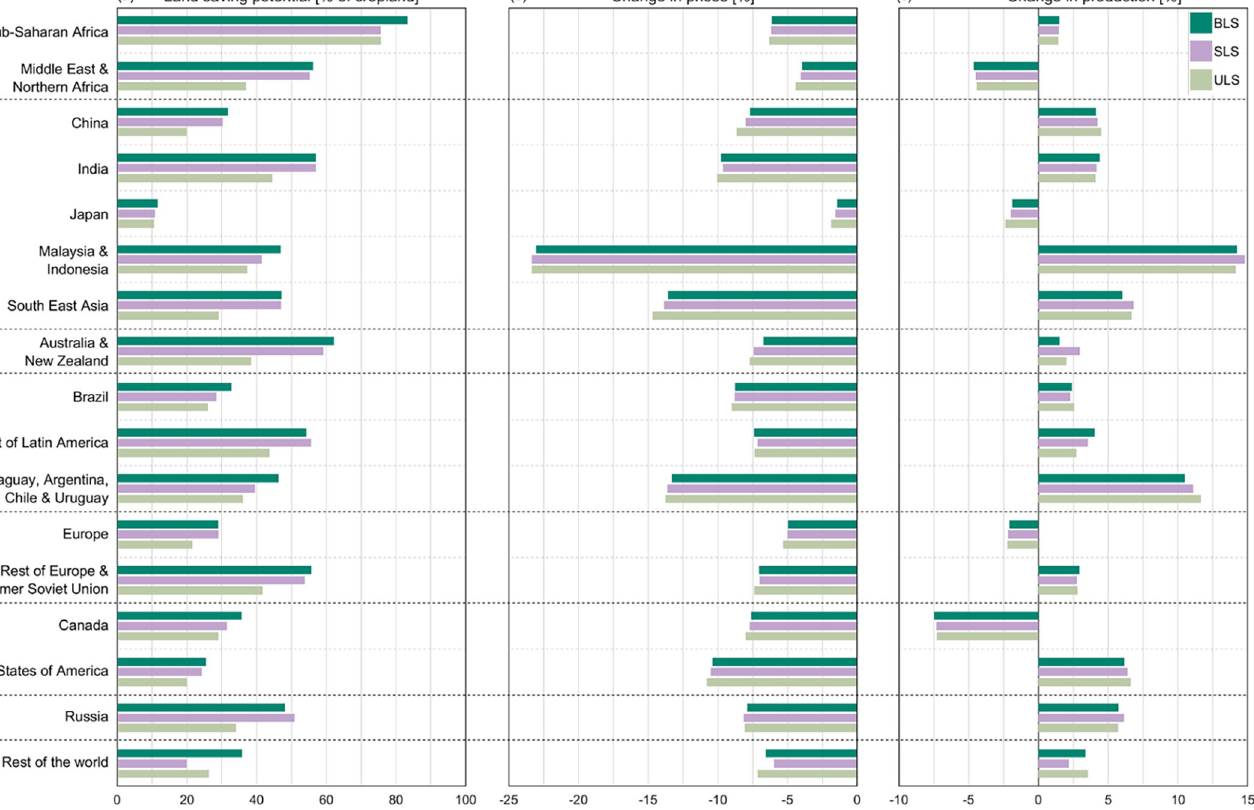
PLOS ONE | https://doi.org/10.1371/journal.pone.0263063 February 22,